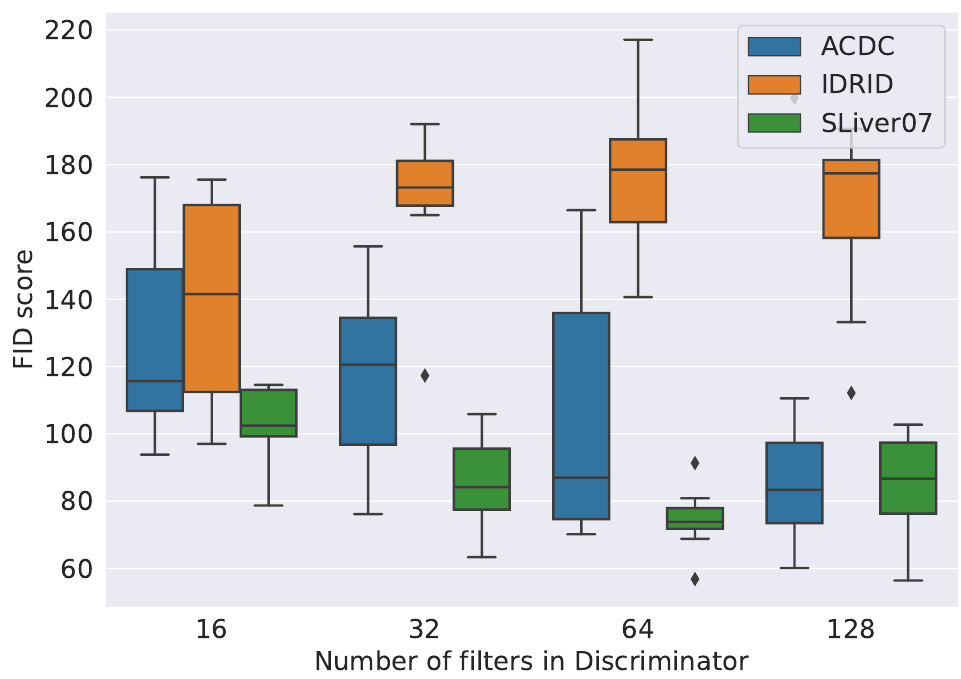
Figure 6. FID score for different number of filters for the discriminator of the DCGAN, LSGAN, WGAN, and